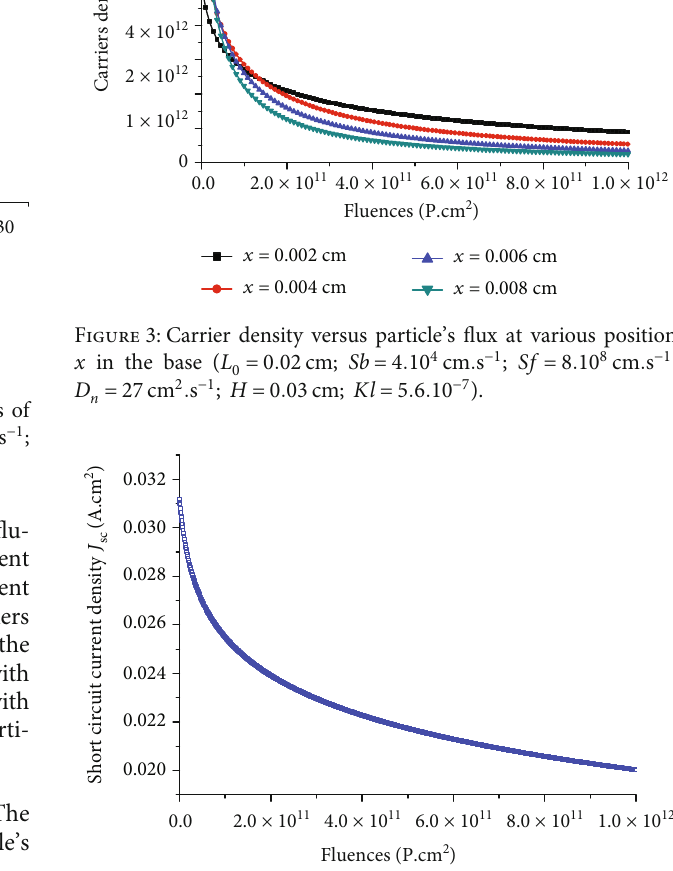
Figure 4: Short-circuit current density versus fl uence ( L Sb = 4 : 10 4 cm : s − 1 ; Sf = 8 : 10 8 cm : s − 1 ; D Kl = 5 : 6 : 10 − 7 ).